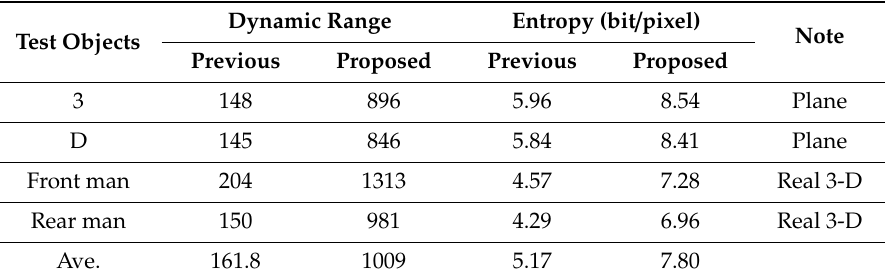
Table 1. Experimental results of objective measures for image